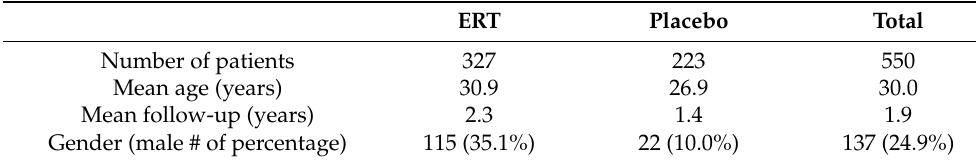
Table 1. Basic patient and study characteristics. Enzyme replacement therapy (ERT). ERT ERT Placebo